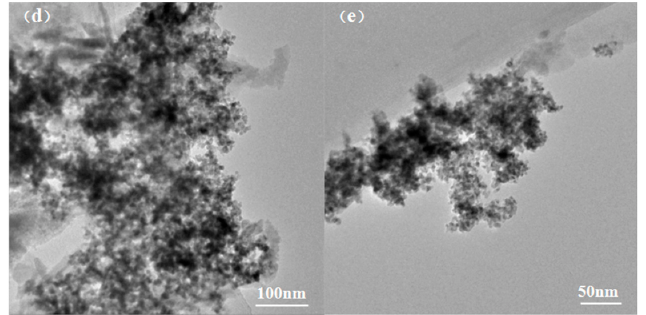
Figure 11. TEM images of Pd/ γ -MnO 2 catalysts prepared under different pH value. ( a ) pH = 3; ( b ) pH = 5; ( c ) pH = 7; ( d ) pH = 9; and ( e ) pH = 11.